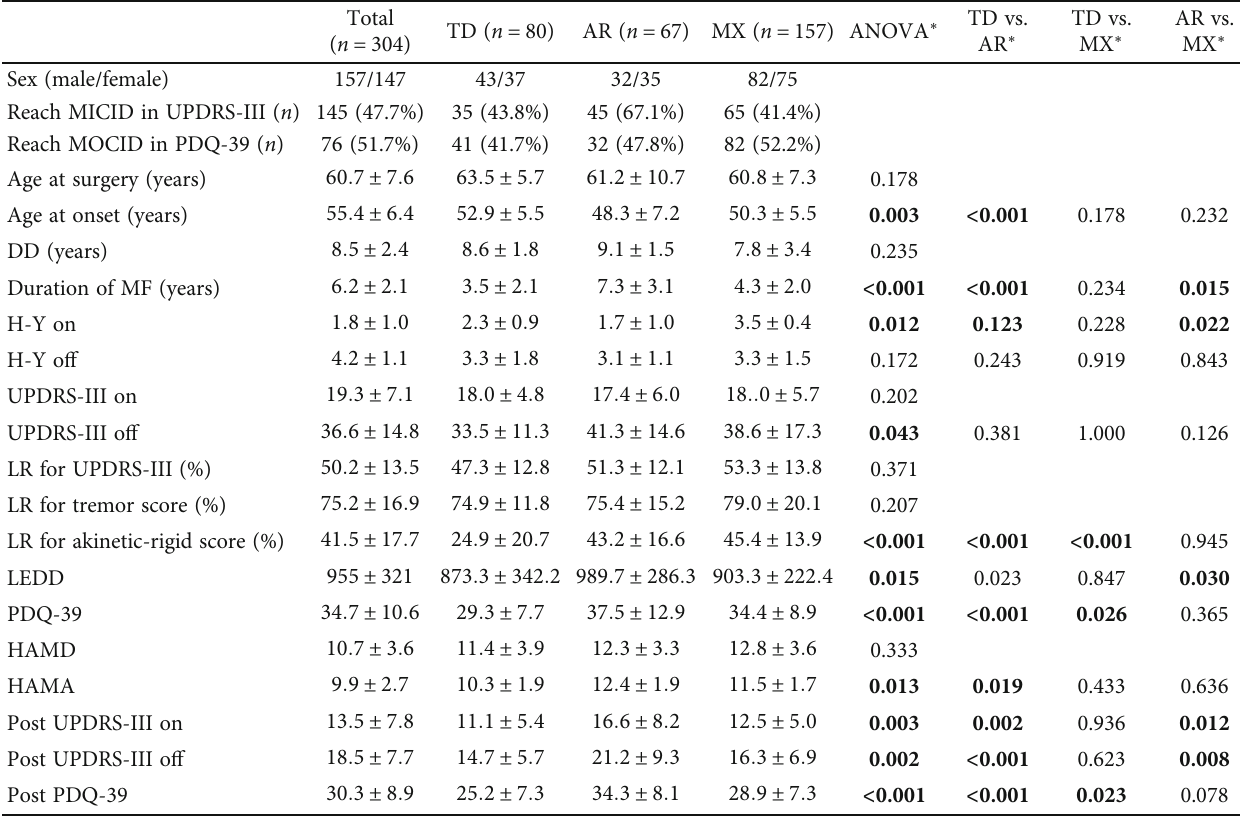
Table 2: Comparison of baseline and postoperative indices among the three subtype groups in the validation set.